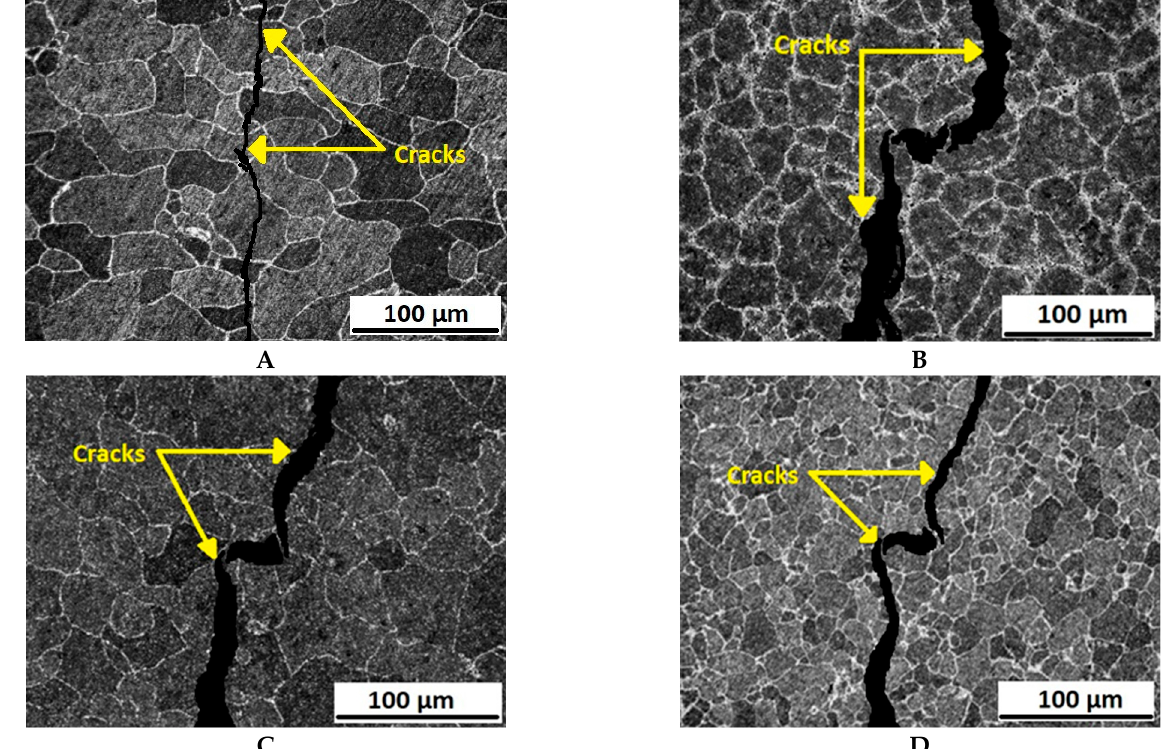
Figure 8. Microstructural analysis of the failed surfaces of Al5083 alloy tested in 3.5 wt.% NaCl solution for the ( A ) as- received sample and for samples after the ( B ) 1st pass, ( C ) 2nd pass, and ( D ) 3rd pass.